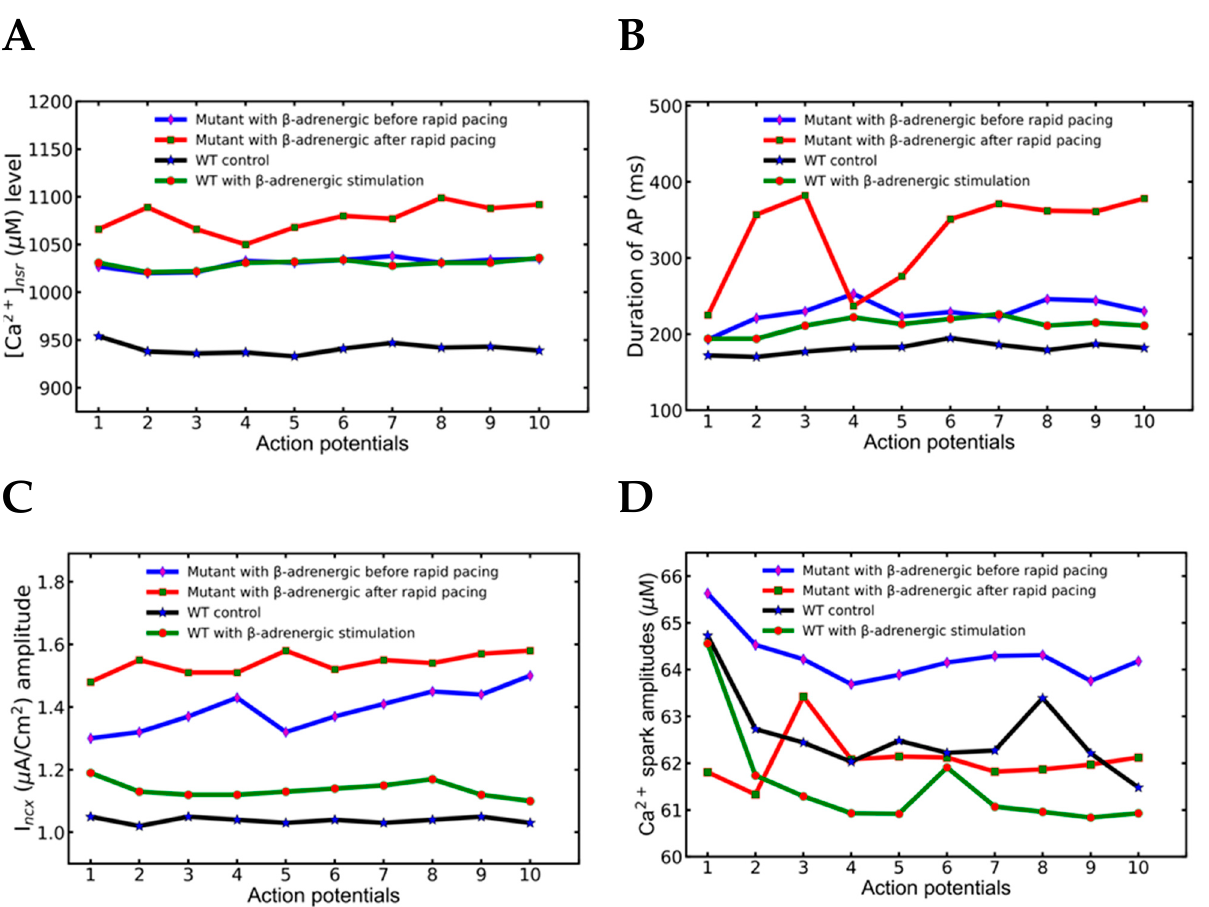
Figure 5. A comparison of intracellular Ca 2+ activities of first and second slow phases of the mutant myocytes under β -adrenergic receptor with WT myocyte with or without β -adrenergic receptor- stimulated. The legend in each panel ( A – D ) indicates which simulation corresponds to which trace. The simulation was repeated 10 times with different seeds for the pseudo random number generator and the patterns observed were repeated each time. Shown here is a representative simulation. Table 4. APD, average Ca 2+ sparks count, and their amplitudes in myocytes (1